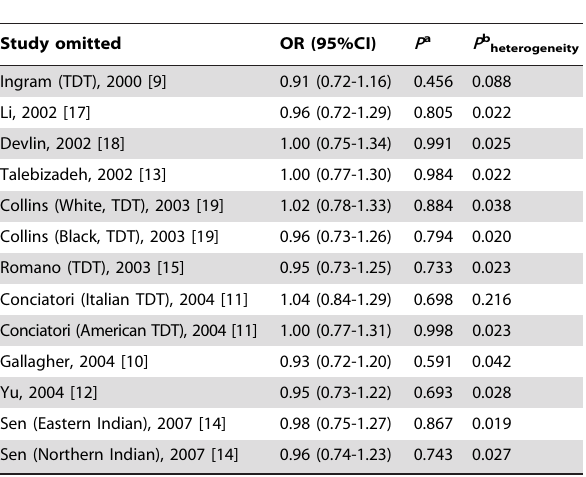
Table 4. Sensitivity analysis of pooled OR combining family- based and case-control studies for HOXA1 A218G polymorphism.